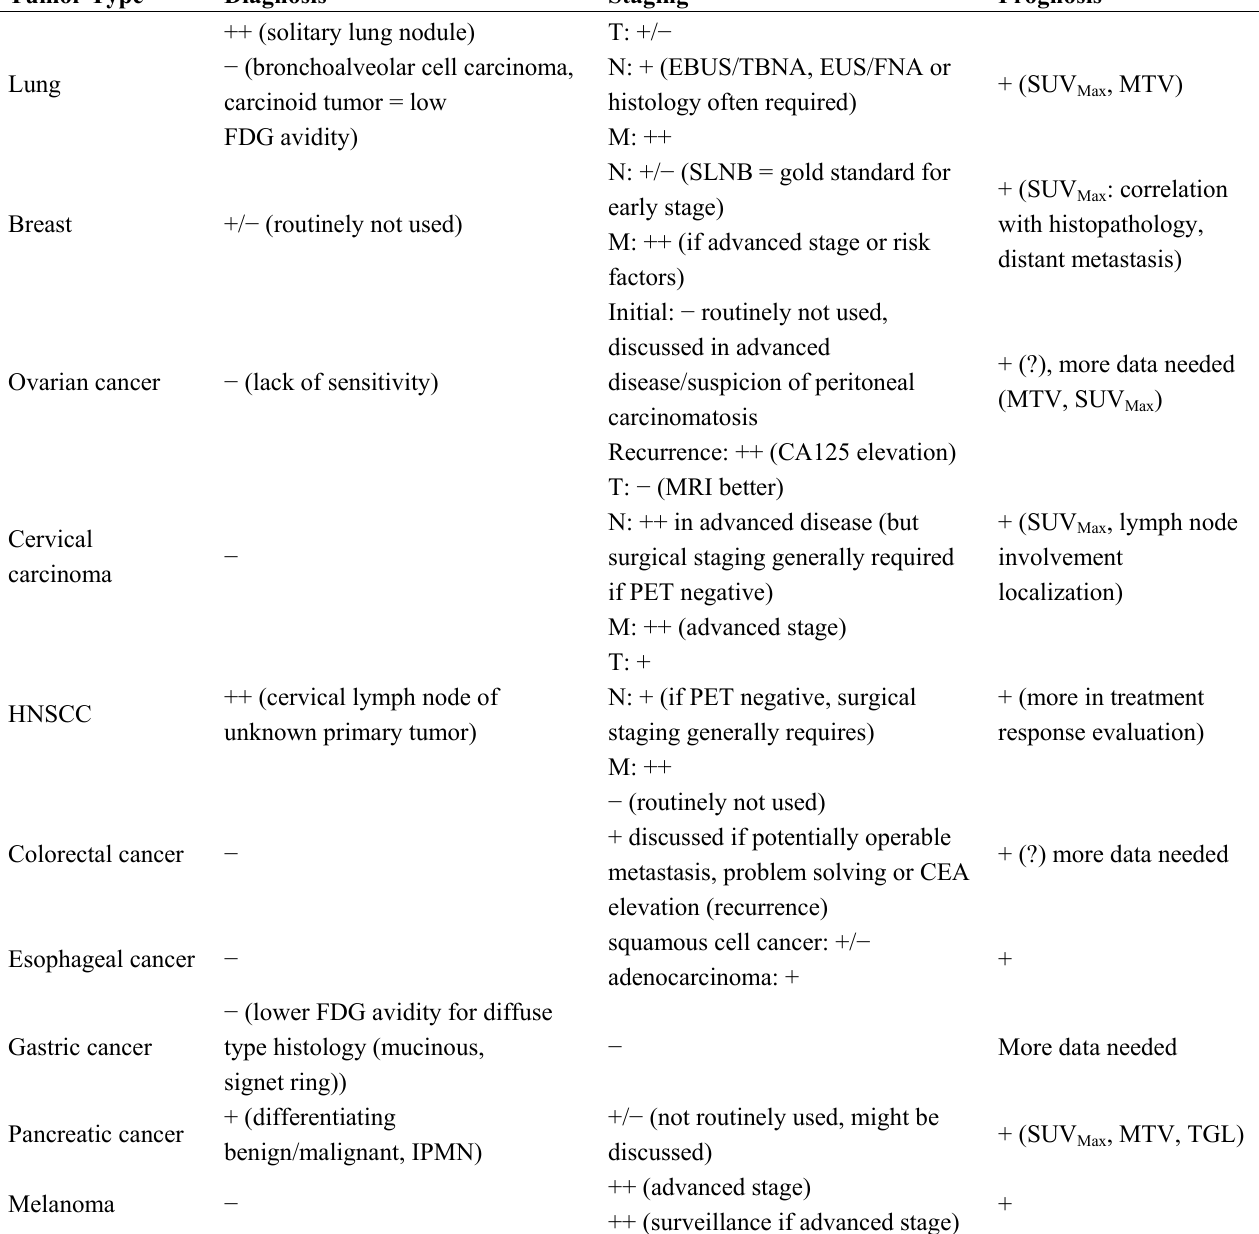
Legend of Table 1: −: PET not routinely recommended; +: for staging, PET indication may be discussed; interesting for prognosis; ++: PET